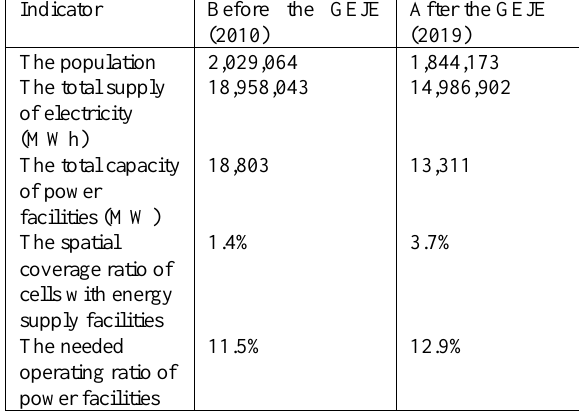
Table 2. The indicators related to the energy supply and consumption in Fukushima Prefecture before and after the